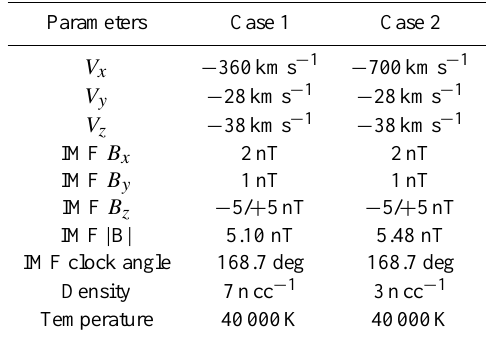
Table 1. Solar wind plasma input parameters. Parameters